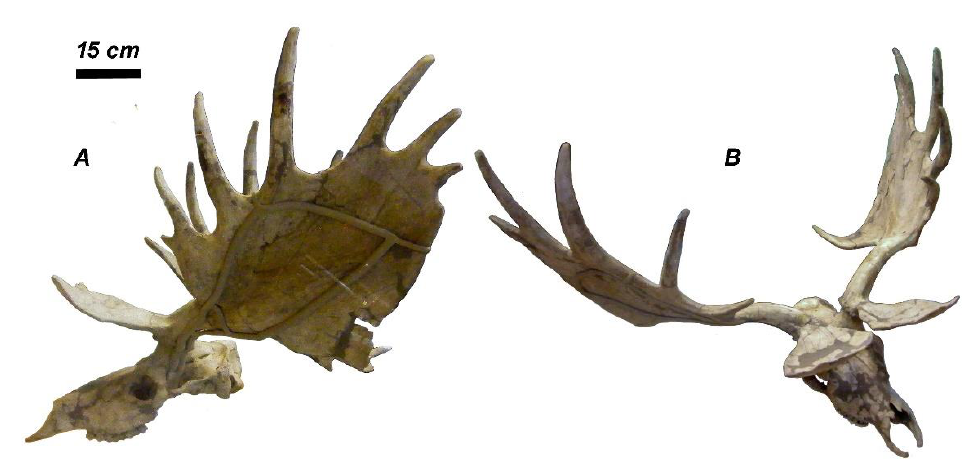
Figure 9. The holotype of Megaloceros giganteus antecedens (Berckhemer, 1941) from Steinheim (Nr. 15795, MNHS): ( A ), side view; ( B ), oblique view.